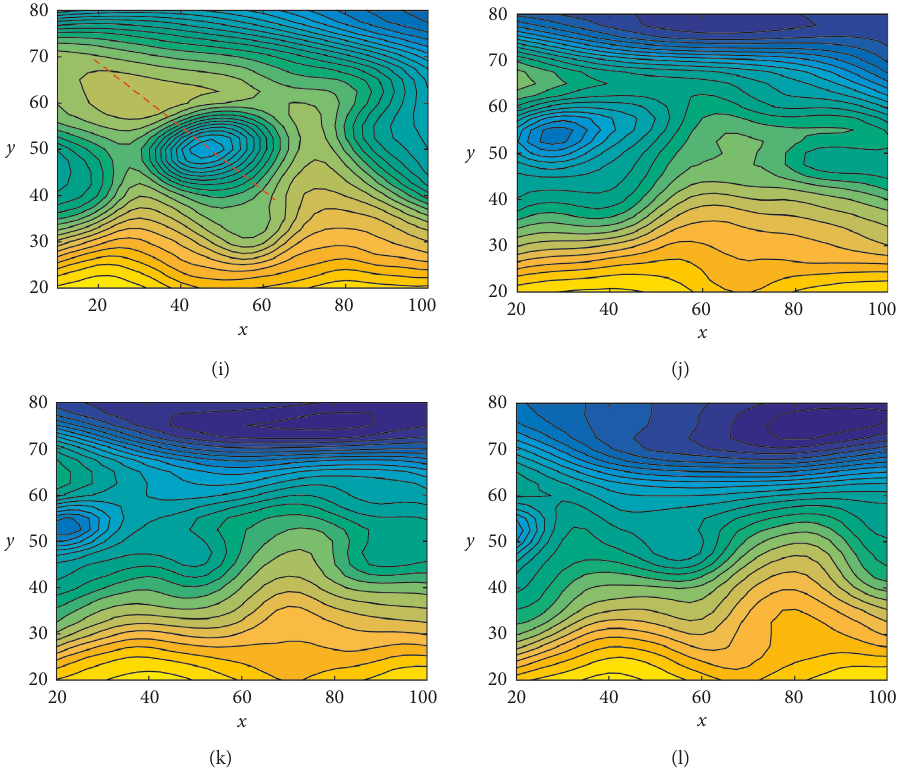
Figure 3: Geopotential height at the 500hPa pressure level of the Urals dipole blocking case from 25 January 1986 to 5 February 1986. The x axis is the longitude, and the y axis is the latitude. (a) 25 January, (b) 26 January, (c) 27 January, (d) 28 January, (e) 29 January, (f) 30 January, (g) 31 January, (h) 1 February, (i) 2 February, (j) 3 February, (k) 4 February, and (l) 5